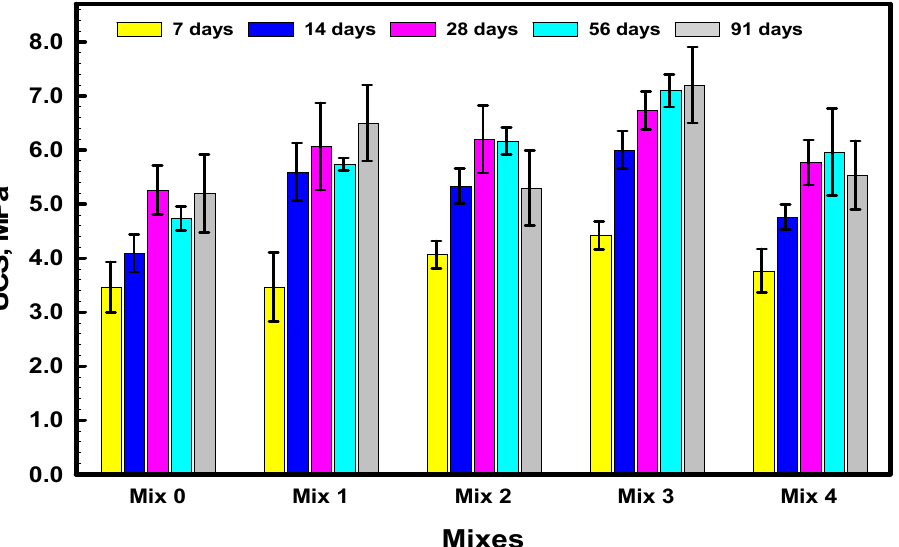
Figure 8. Compressive strength results of the various sample sets prepared from the different mixtures cured at several curing ages.